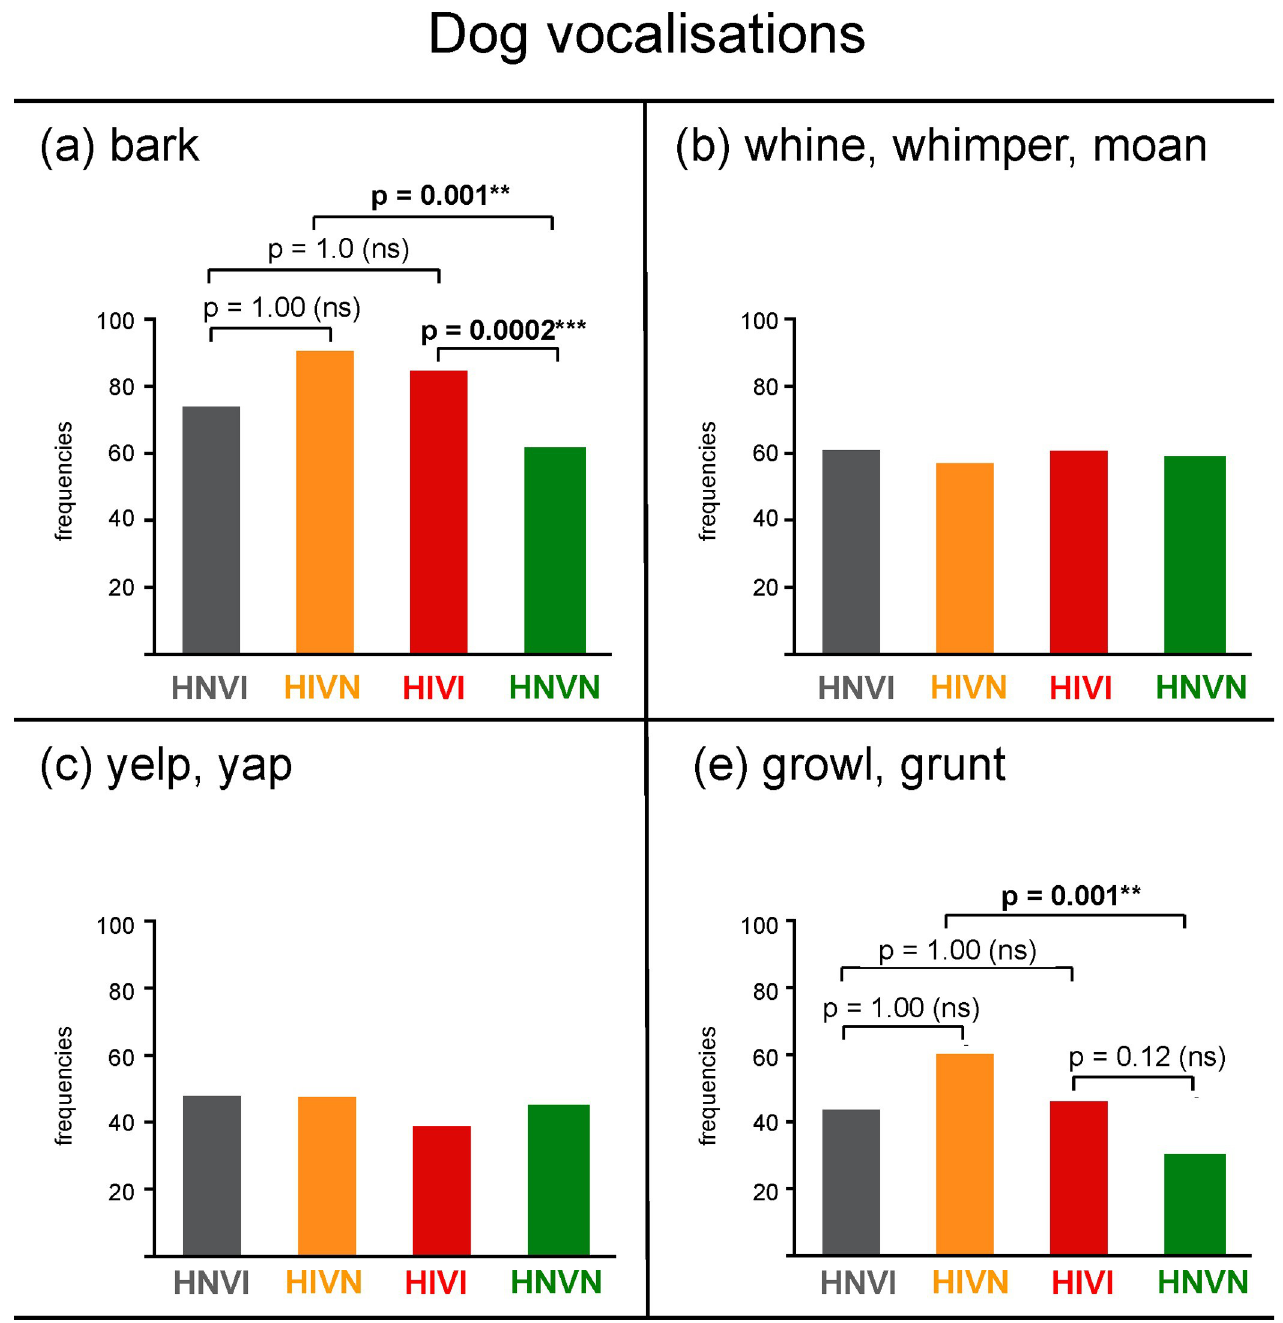
Fig 8. Frequencies of responses, in percentages, obtained for each group for the following dog vocalisations: (a) barks, (b) whines, whimpers, moans, (c) yelps, yaps, and (d) growls, grunts. HNVI = hearing normal vision impaired (grey), HIVN = hearing impaired vision normal (orange), HIVI = hearing impaired vision impaired (red), HNVN = hearing normal vision normal (green), ns = non significant. Brackets show the two-by-two comparisons that were assessed using Chi 2 tests following visual inspection of the